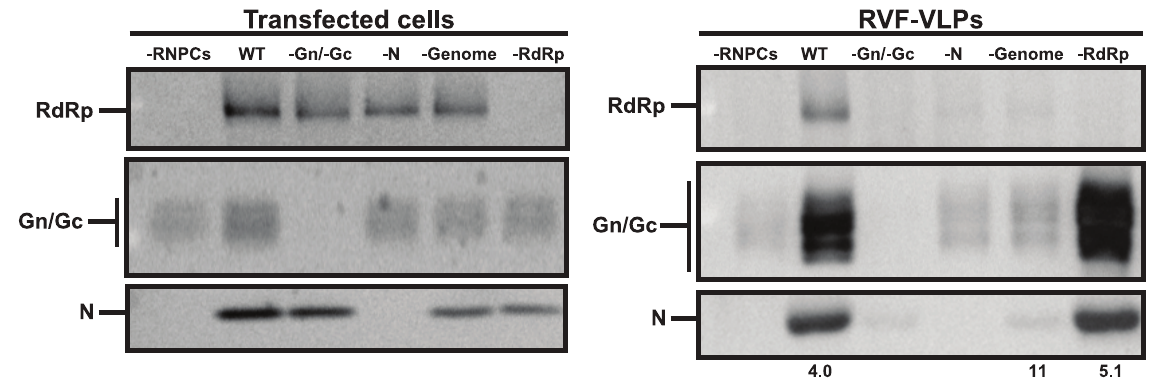
Figure 6. Viral components required for efficient RVF-VLP release. BSR-T7/5 cells were transfected with genome and all of the structural proteins (WT), or one or more of the components was replaced with an equivalent amount of empty vector (-RNPCs, -Gn/Gc, -N, -genome, -RdRp). RNPCs refer to ribonucleoprotein complexes and are defined as genome, N, and RdRp. Transfected cells were analyzed for protein expression by immunoblot. RVF-VLPs were immune precipitated from the clarified media from transfected cells and analyzed by immunoblot. The numbers below the immunoblots indicate the ratio of glycoprotein to N signal.